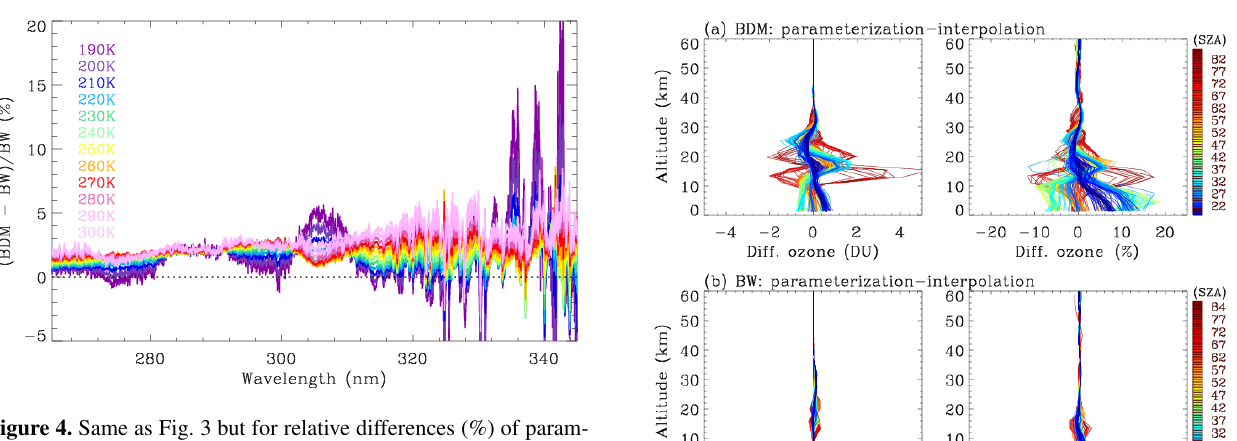
Figure 4. Same as Fig. 3 but for relative differences (%) of param- eterized ozone cross-sections of BDM and BW.